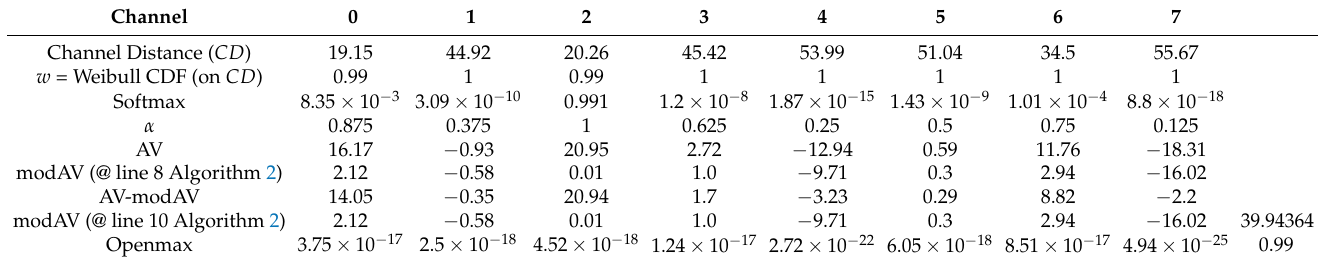
Table 5. Intermediate parameters of the Openmax algorithm given an unknown input radar image. Channel